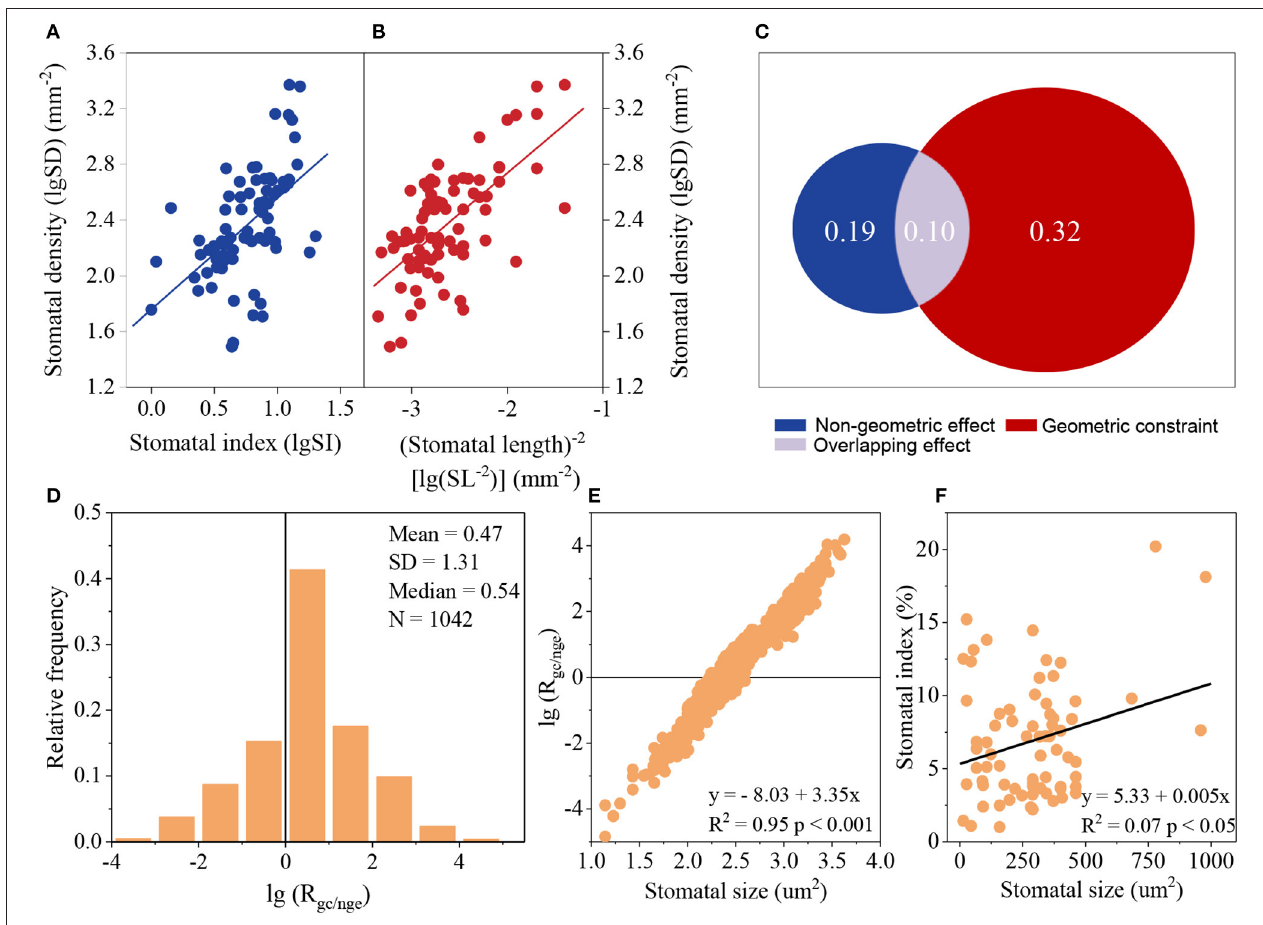
FIGURE 4 | Comparison of the effect of the geometric constraint and non-geometric effect on stomatal density (SD) according to variation partitioning (A–C) and a partial differential equation (D–F) . (A,B) : relationships between SD and stomatal index (SI) (A) and between SD and (stomatal length) − 2 (SL − 2 ) (B) ; lgSD = 1.76 + 0.797 lgSI, R 2 = 0.29, p < 0.001, N = 77; lgSD = 3.90 + 0.581 lgSL − 2 , R 2 = 0.42, p < 0.001, N = 77. (C) Comparison of the geometric constraint and non-geometric effect calculated by variation partitioning using the relationship between SD and SI (A) and SD and SL − 2 (B) . (D) Relative frequency of the ratio of